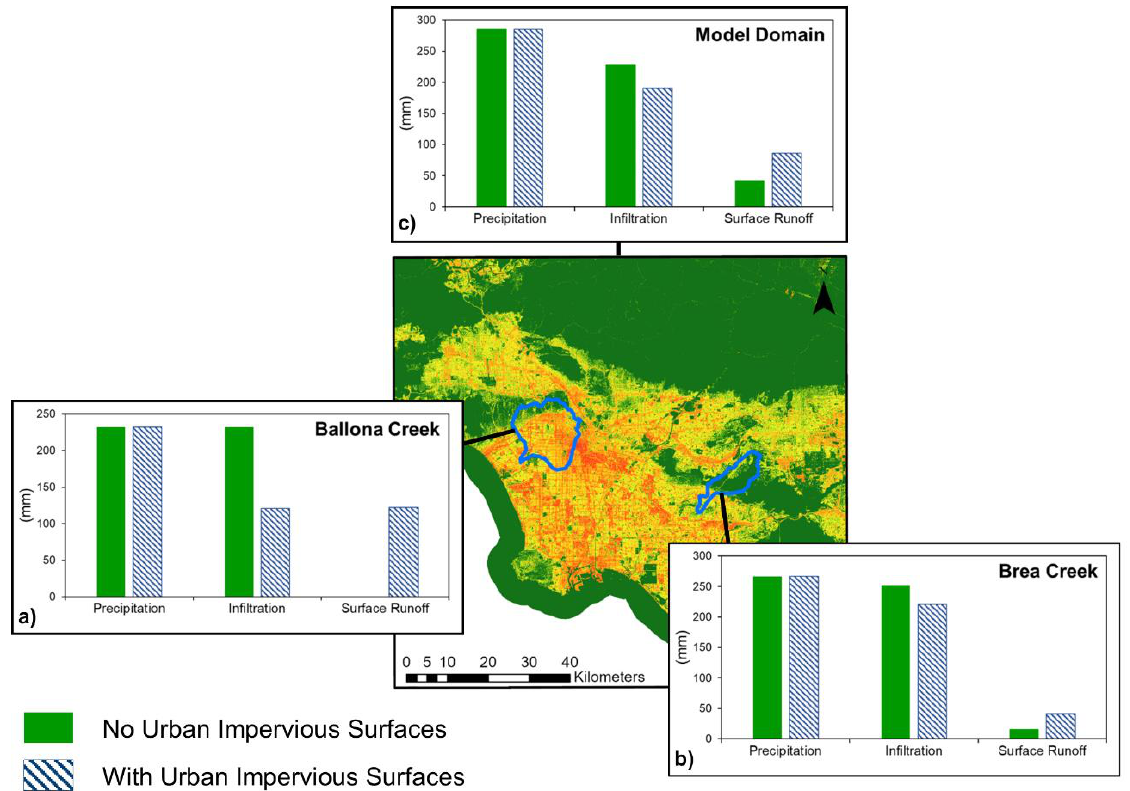
Figure 8. Impact of impervious surfaces on main water budget components in ( a ) Ballona Creek, ( b ) Brea Creek, and ( c ) for the LA metropolitan area. Infiltration combines water stored in the soil and deep drainage. The error term was less than 5% of the total budget in all simulations. Accumulated evapotranspiration was close to 0 mm in both scenarios due to high humidity conditions.